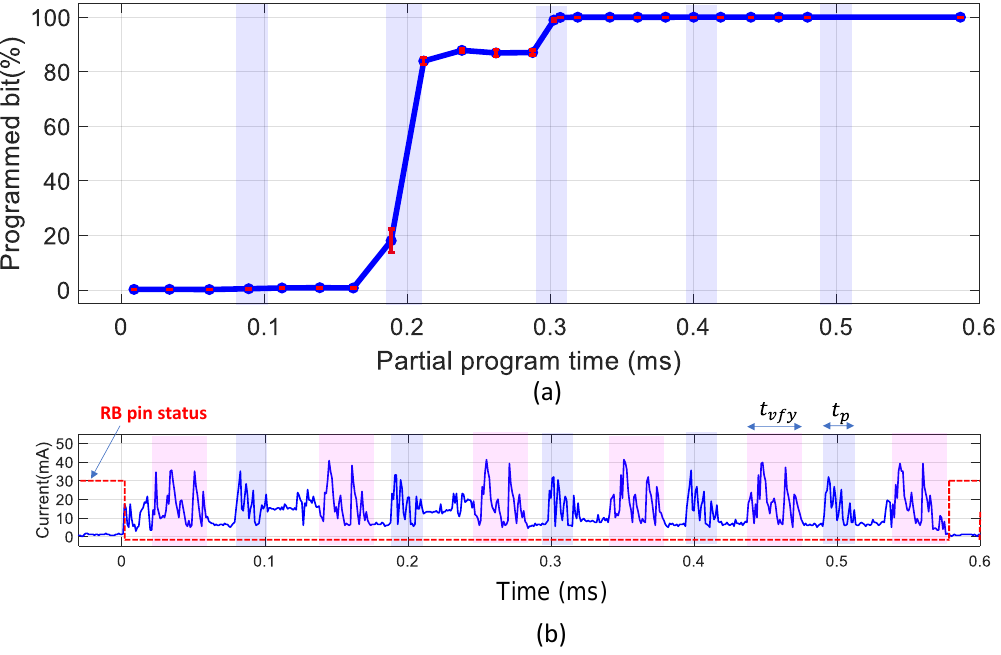
Figure 6. Effects of partial-page program operation: ( a ) percentage of programmed bits in an SLC memory page as a function of partial-page program time, t pp ; ( b ) the current drawn by the memory chip during a regular-page program operation.